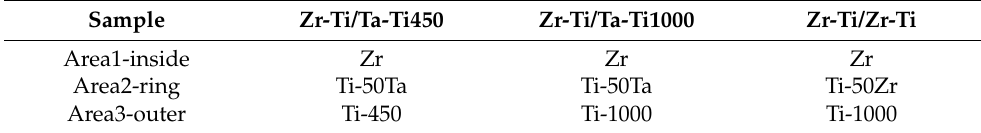
Figure 1. Schematic representation of sample construction. Table 1. Schematic representation of sample